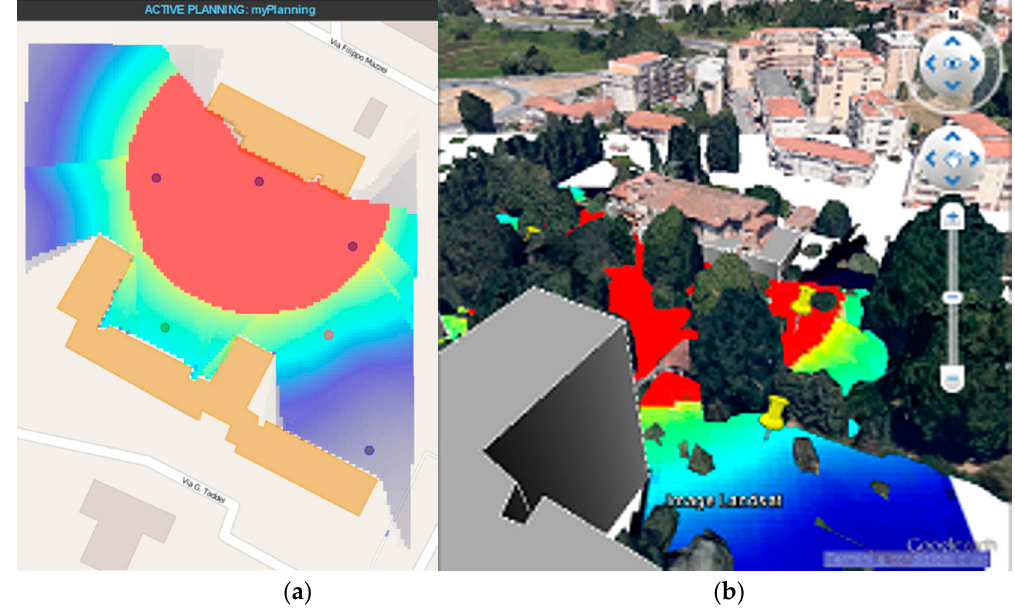
Figure 5. 2D graphical display of the computed field radiated by one of the nodes ( a ) that can be superimposed to Google Earth image of the area ( b ).